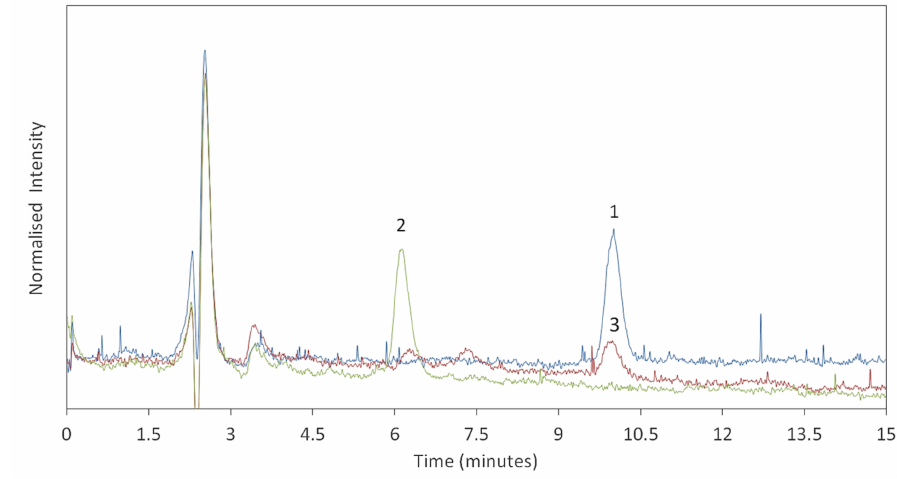
Figure 5. Normalised intensity vs. retention time (minutes) of solutions containing: Cr(VI) (blue), extract from leather containing a red dye (red), extract from leather containing a yellow dye (green).